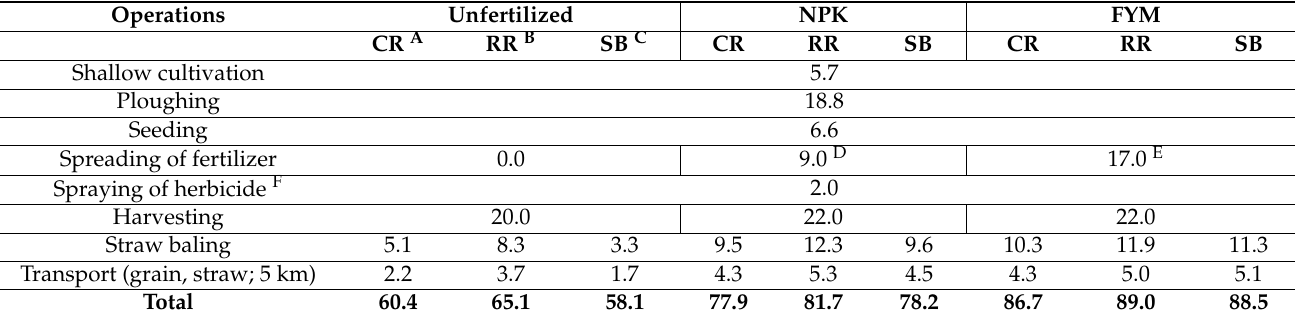
Table 5. Diesel fuel consumption (L ha − 1 ) for continuous winter rye, winter rye in rotation and spring barley in rotation. Operations Unfertilized Shallow cultivation Ploughing Seeding Spreading of fertilizer